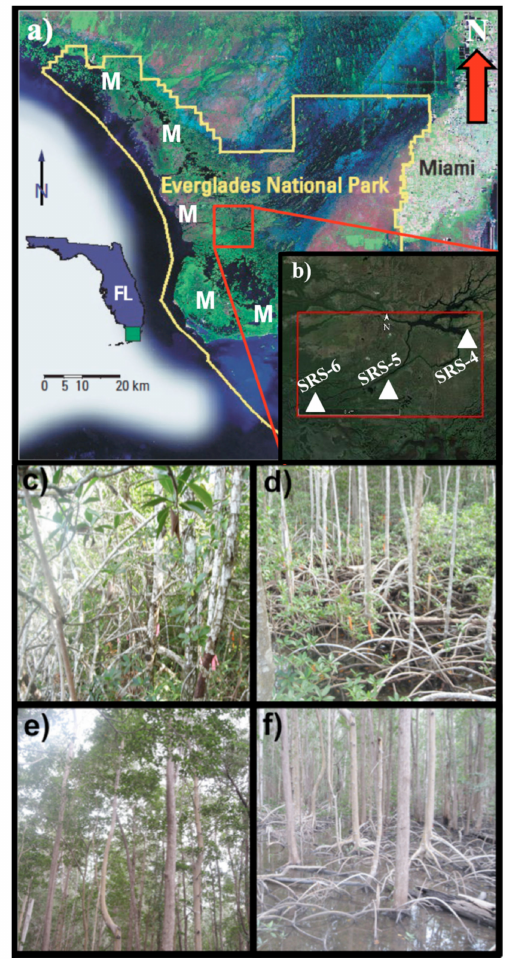
Figure 1. ( a ) Everglades National Park (ENP) location map within the South Florida Peninsula showing mangrove (M) forests location; ( b ) Zoom-in to Shark River Slough (SRS) area. The red polygon shows SRS sites; ( c ) Short mangrove stands (SRS-4); ( d ) Intermediate mangrove stands (SRS-5); ( e ) Tall mangrove stands (SRS-6); ( f ) Tall mangrove stands